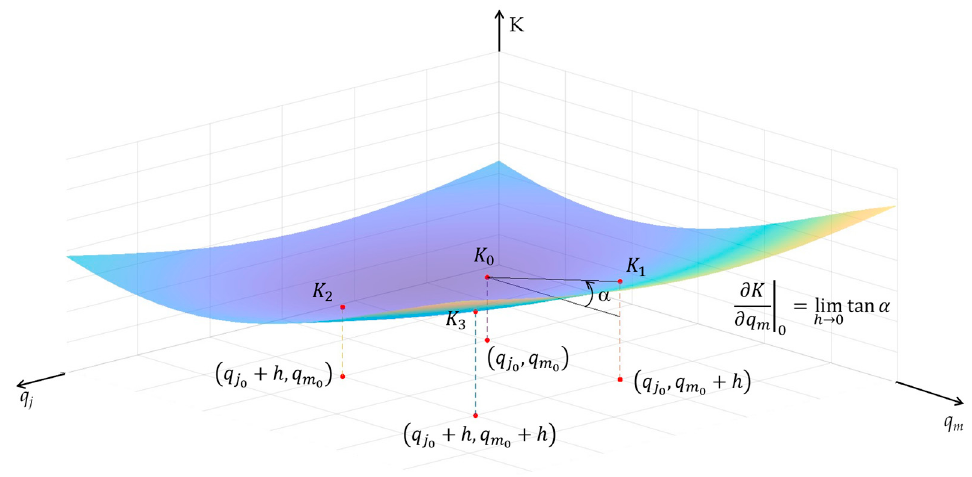
Figure 3. Selected points to calculate the first- and second-order derivatives.